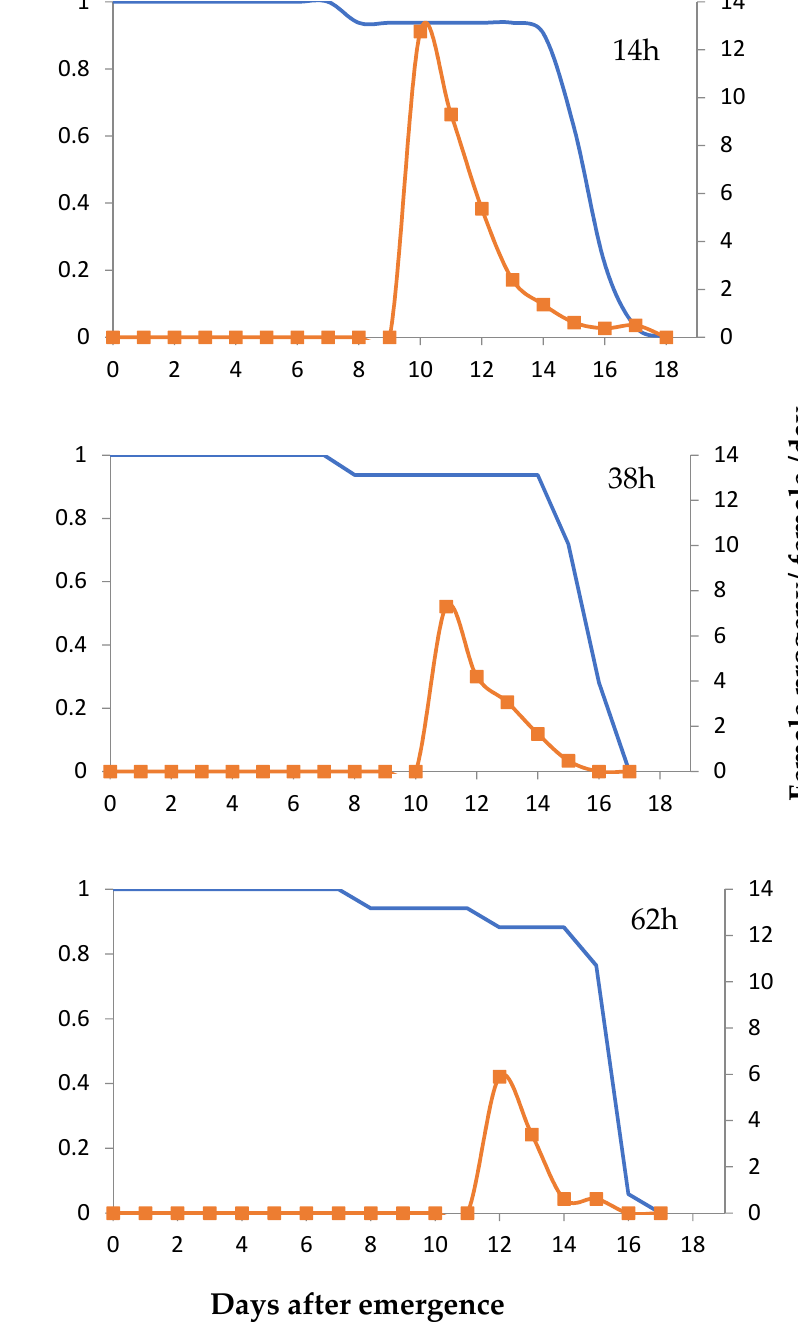
Figure 1. Proportional survivorship ( l x , solid blue lines) and number of T. euproctidis female progeny per female per day ( m x , dotted orange lines) from H. armigera eggs of different ages.